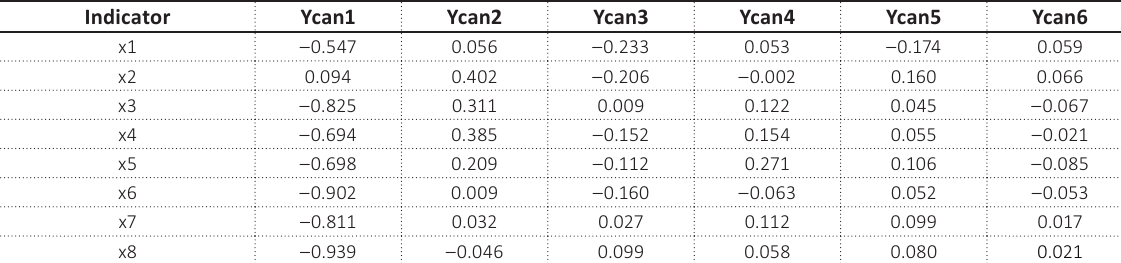
Table 8. Cross-loading of higher education and training indicators with labor market efficiency canonical variates